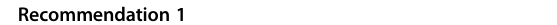
Table 2 Efficacy of traditional NSAIDs or iCOX2 vs. placebo in patients with axial spondyloarthritis: meta-analyses of randomized clinical trials